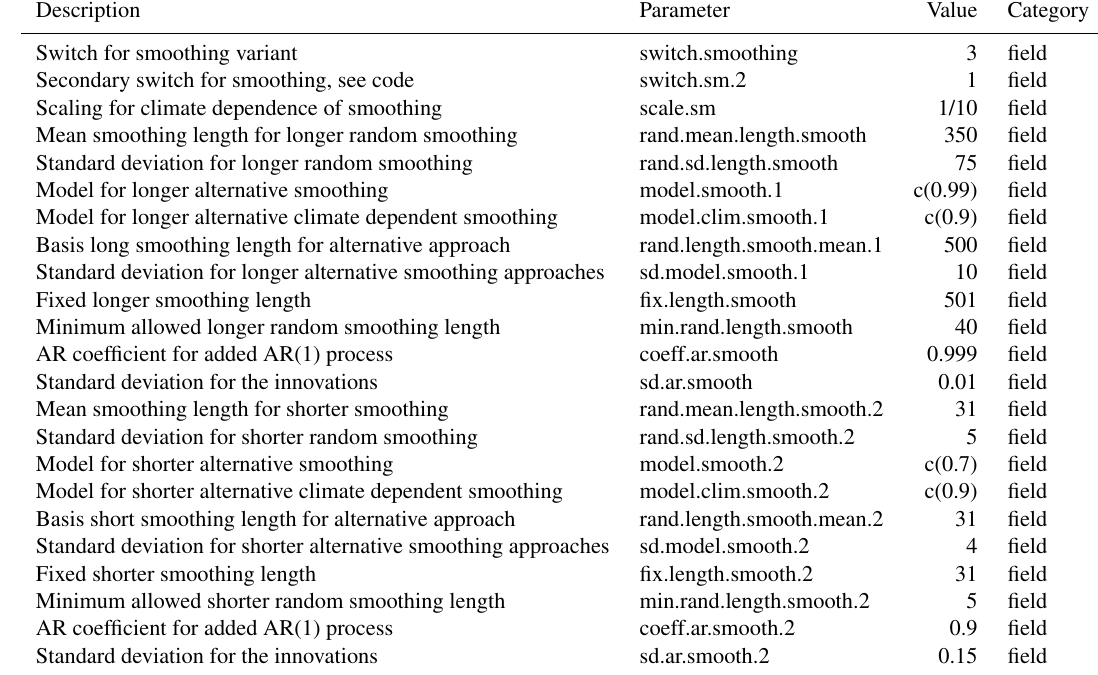
Table A2. Continuation of list of parameters